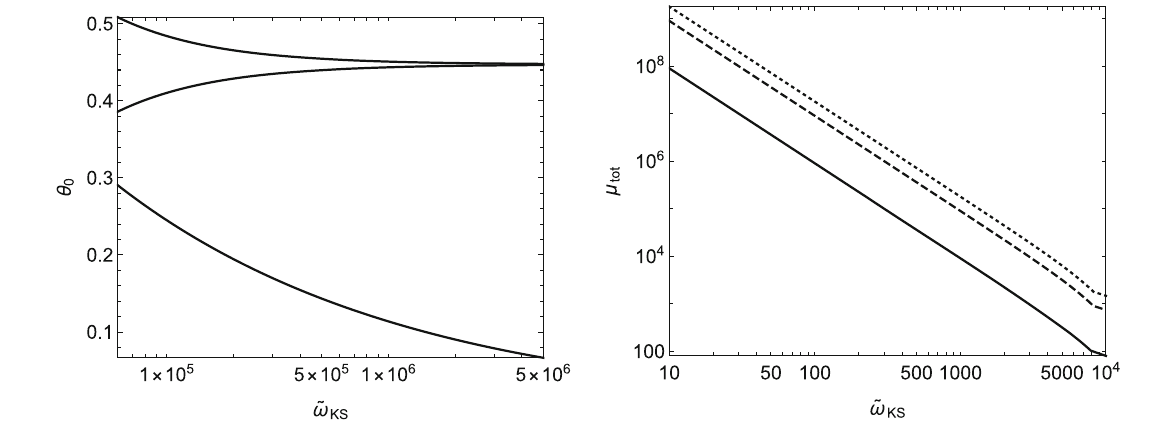
Fig. 7 Vacuum case: On the left panel, we plot dependence of three of source from observer-lens axis( β ): 0.01 (solid line), 0.001 (dashed Einstein angles ( θ 0 ) with dimensionless “Hoˇrava parameter” ( ω ). On line), 0.0005 (dotted line). Both plots are considering M / D l = 10 and KS the right panel, we plot the total magnification of image brightness with dimensionless “Hoˇrava parameter” ( ω ) for different values of angle KS